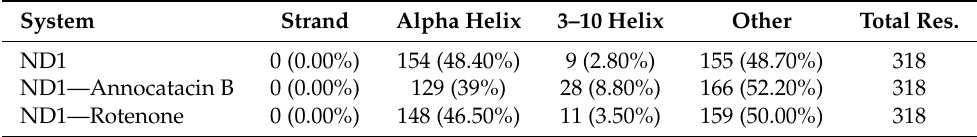
Table 1. Secondary structure